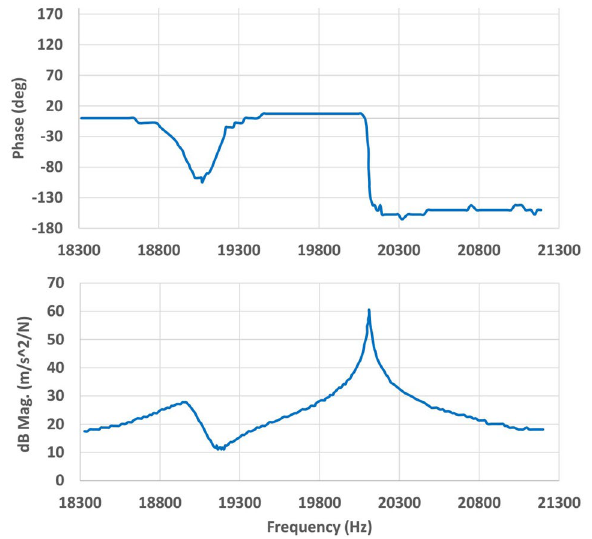
Fig. 11 Booster’s frequency response function (FRF) diagram